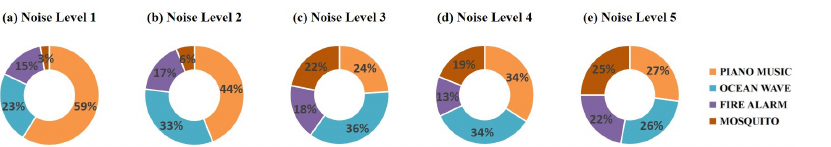
Figure 10. The signal absolute difference integral proportion difference between audio with five levels of noise and raw audio under four different audio